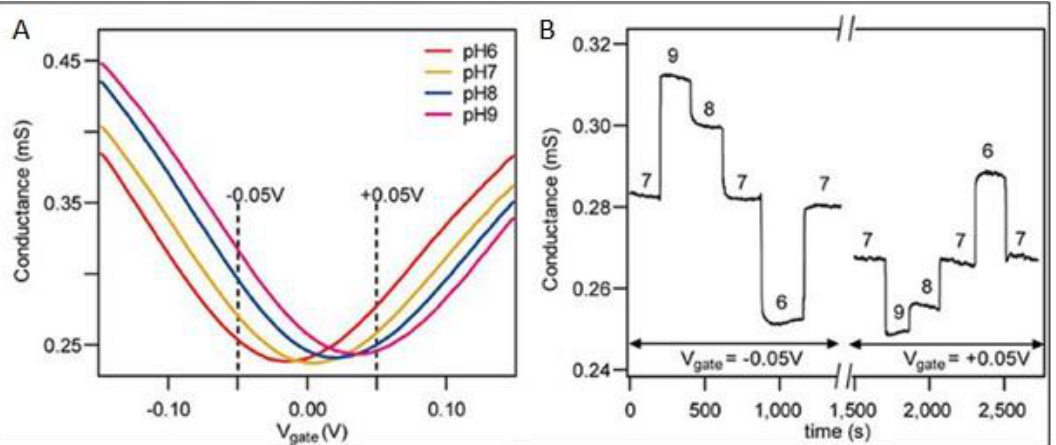
Figure 4. Glucose detection performance with ( A ) CVD Graphene FET and ( B ) response curves of glucose to different gate voltages. Reprinted with permission from Ref. [47]. 2012, Elsevier.